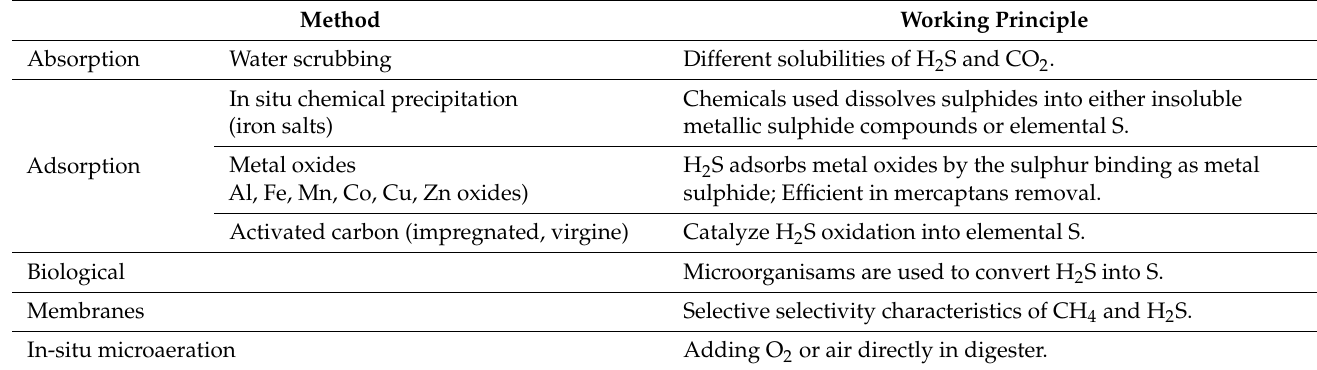
Table 4. Biogas purification methods (modified to Adnan et al. [82]).